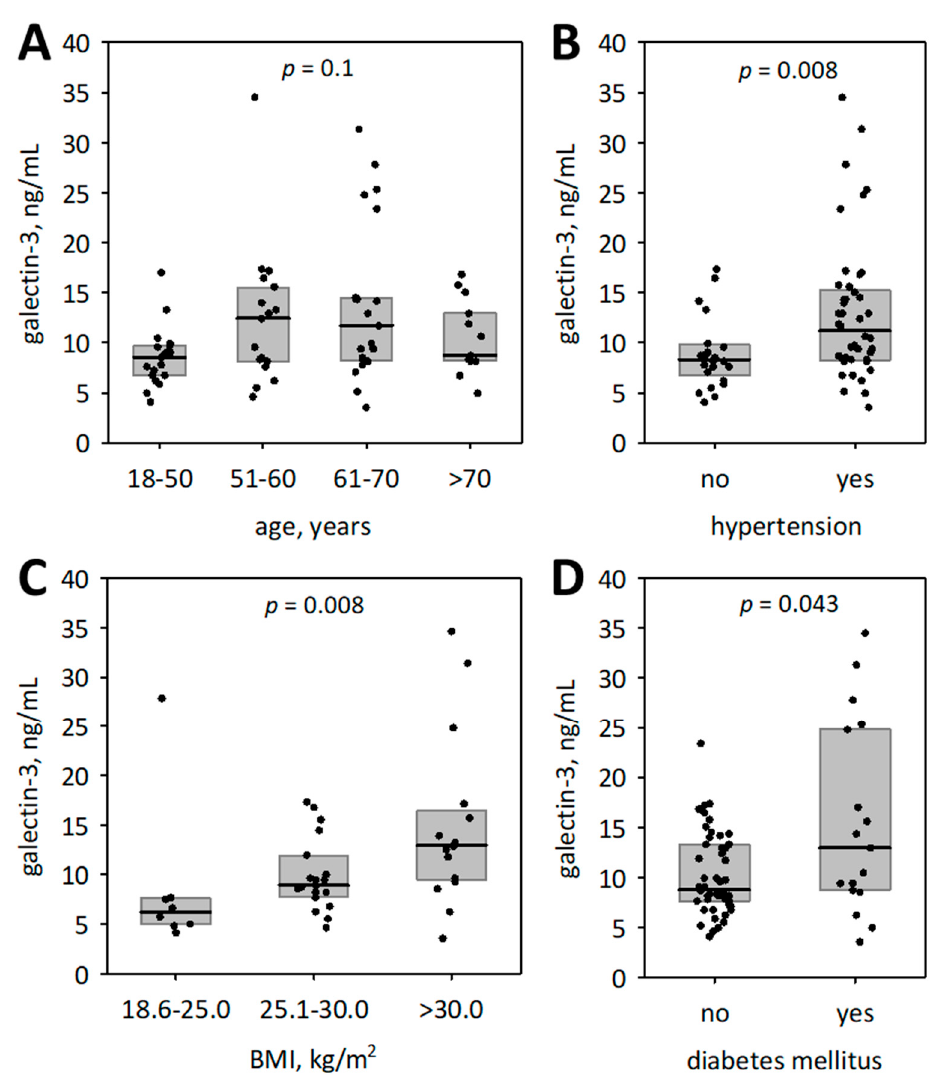
Figure 2. Serum galectin-3 concentrations according to age categories ( A ), the status of hypertension ( B ), overweight/obesity ( C ), and diabetes mellitus ( D ). Medians are represented by the central lines; interquartile ranges are represented by the boxes; raw data are shown as points; p -values were calculated using Kruskal–Wallis ANOVA or Mann–Whitney test. Table 5. Statistically significant correlations between galectin-3 and the selected variables. We report the Spearman rank correlation coefficients (R) and p -values.